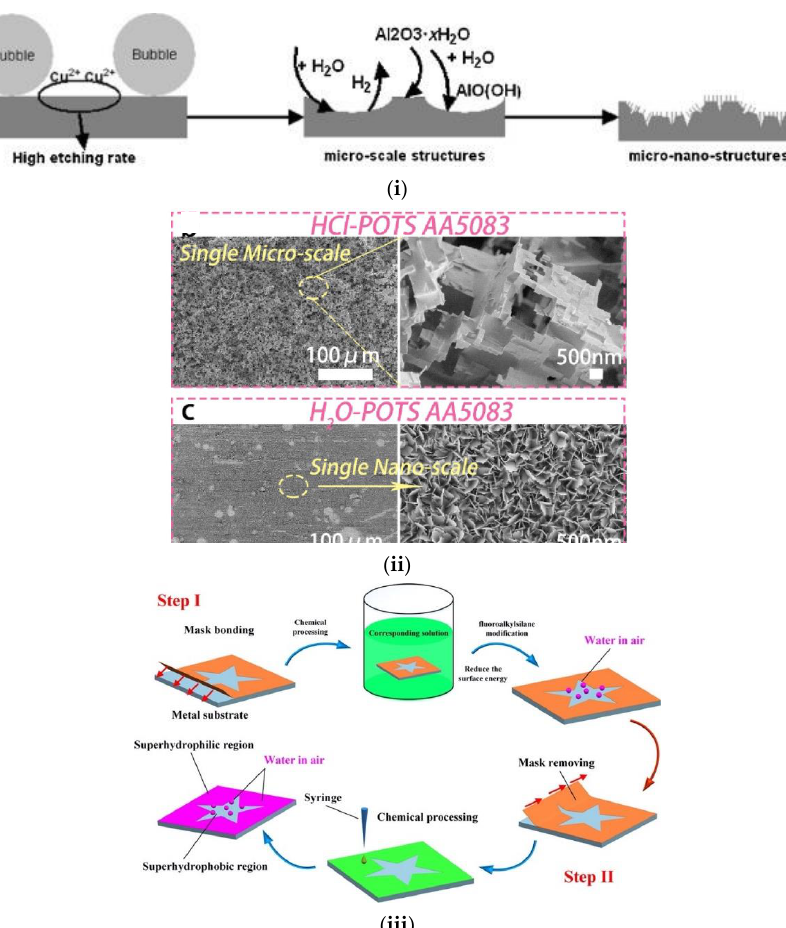
Figure 6. ( i ) Schematic illustration of fabrication micro-nano structures on aluminum used as anti-icing surfaces. Reproduced with permission from [24]. ( ii ) SEM images of superamphiphobic HCl-H 2 O-POTS AA5083. Reproduced with permission from [60]. ( iii ) Fabrication process of different wettability patterns on the same surface. First, a superhydrophobic area is created using a mask based chemical processing and fluoroalkylsilane modification. Then, a superhydrophilic area is created by casting liquid drops. Reproduced with permission from [58].